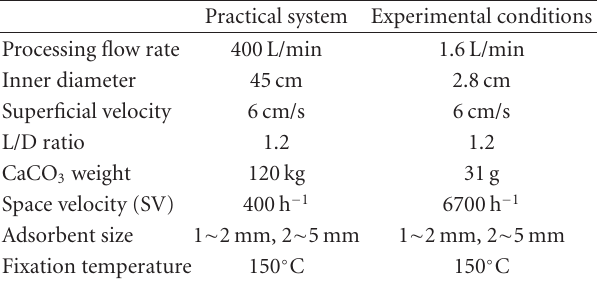
Table 1: Experimental conditions for the gas-solid